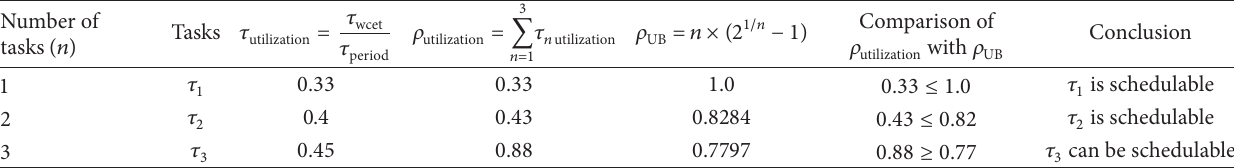
Table 4: Shows some values of 𝜌